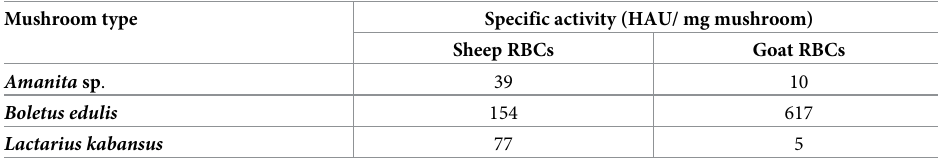
Table 2. Specific activity of crude extracts of mushrooms showing haemagglutination activity. Mushroom type